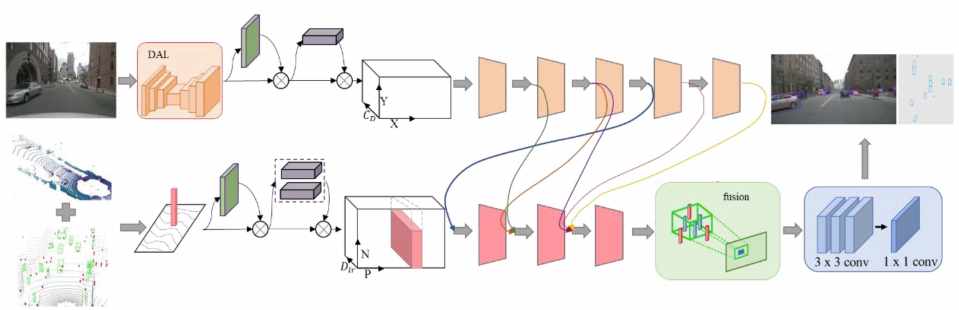
Figure 4. Multi-sensor information fusion network